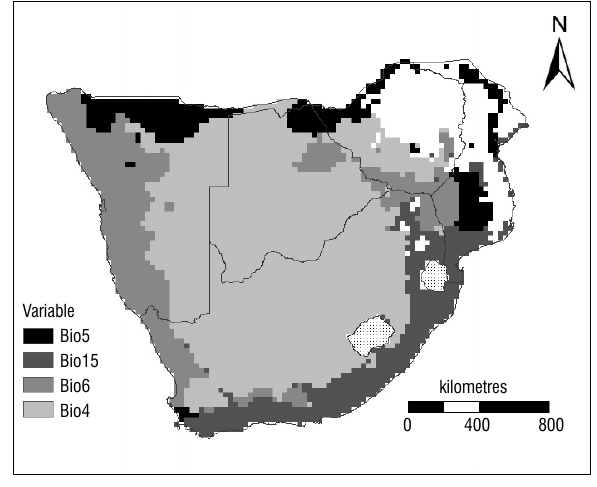
Figure 4: Limiting factors of the present-day ecological niche of Brachystegia spiciformis woodland in southern Africa (excluding Lesotho and Swaziland).